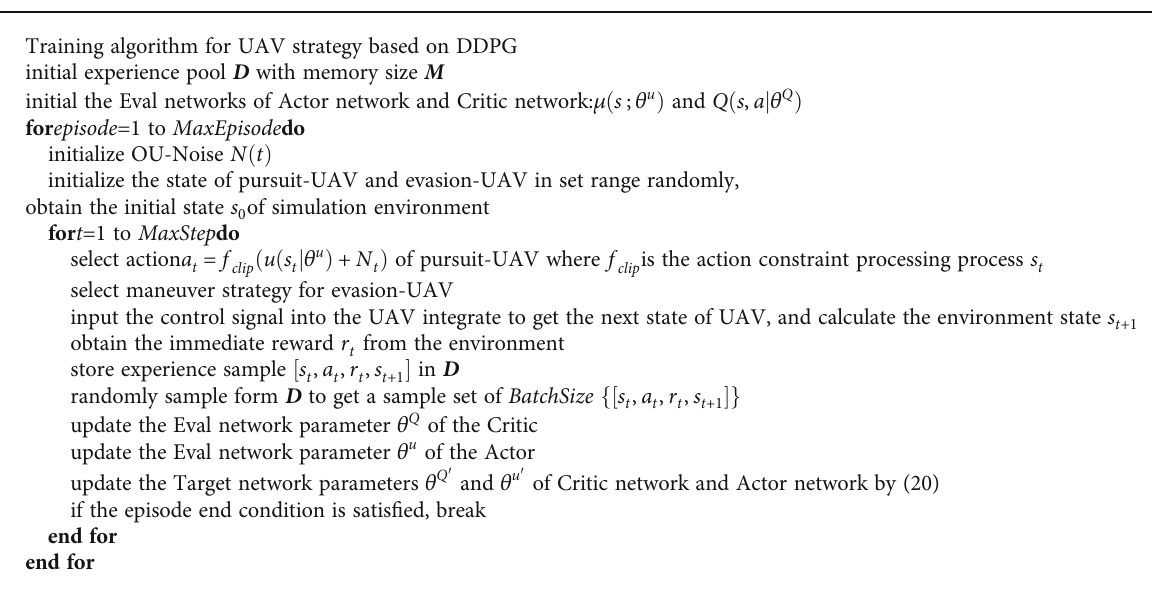
IL-DDPG.Training algorithm for UAV strategy based on DDPG